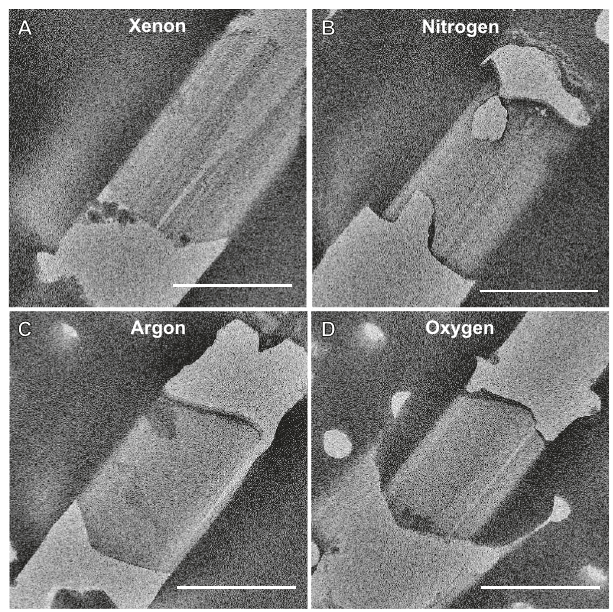
Fig.4|ObservedpathologiesinproteinaseKlamellaepreparedbydifferention sources on the pFIB. A xenon lamella showing breaks and deep curtaining ( B ) nitrogen lamella showing perpendicular holes and curtaining ( C ) argon lamella showing a break and topical ice contamination on the leading edge ( D ) oxygen lamellawithabreak,curtaining,and icecontaminations onthe backedge.Allscale bars 10 µ